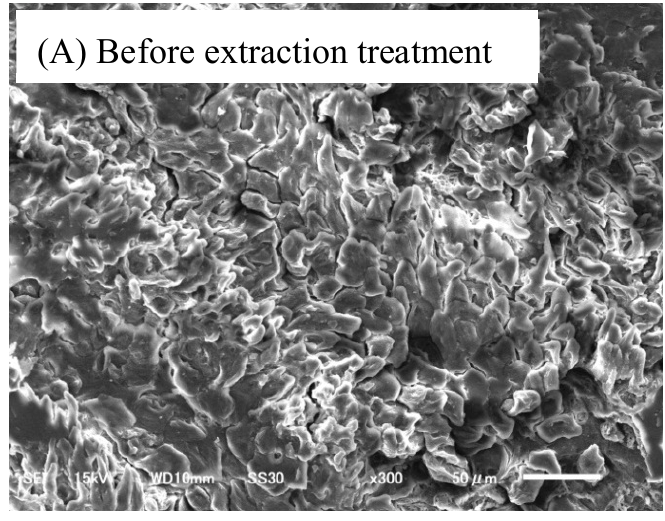
Figure 2. Cont (B) Ultrasonic irradiation extraction